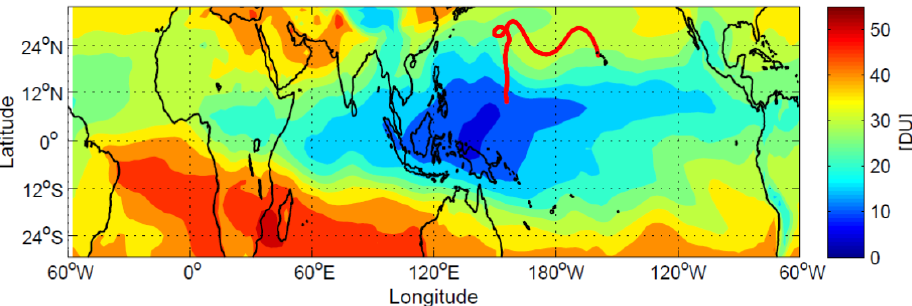
Fig. 3. 12day back trajectory (red line) ending close to Hawaii of the air mass, which is indicated by the red circle in Fig. 2. Color indicates the tropospheric ozone column from GEOS-Chem as in Fig.